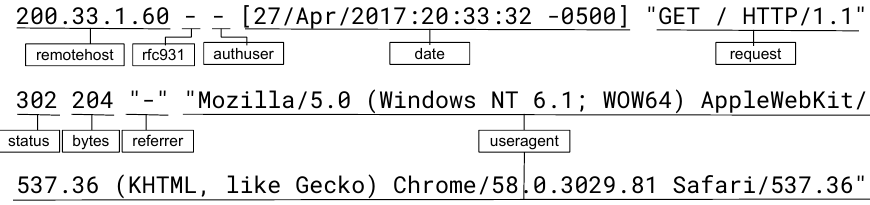
Figure 3. Example of line in a logfile, using the Combined Log